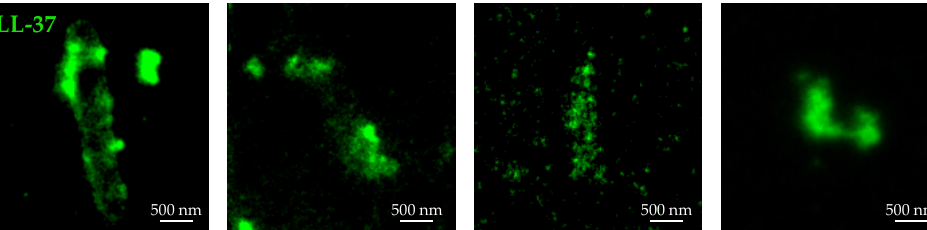
Figure 2. E ff ect of LL-37-TAMRA on extracellular Mtb . ( A ) Antimicrobial activity of unconjugated LL-37 and LL-37-TAMRA (11 µ M) against extracellular Mtb was determined by incorporation of 3 H-Uracil. The graph shows the mean percentage activity ± SD of five independent experiments. Statistical analysis was performed using the Kolmogorov–Smirnov-test to compare cumulative distributions ( p > 0.99). ( B ) Unstained extracellular Mtb were treated with LL-37-TAMRA for 5 min. An XZ-scan of the bacteria (along the dotted white line) is shown. ( C ) Unstained extracellular Mtb were treated with LL-37-TAMRA for 30 min. Examples of a cell with relatively maintained structural integrity (left) and completely disrupted cellular morphology (right) are shown. ( B , C ) Depicted images show one representative Mtb out of ten examined bacteria per experiment (n = 3). Images were acquired by STED imaging with a pixel dwell time of 300 µ s and a pixel size of 20 nm. Scale bar is 500